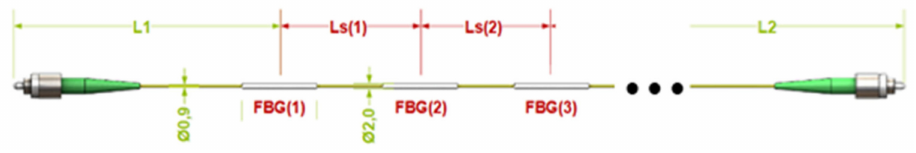
Figure 3. Fibre Bragg grating (FBG) temperature